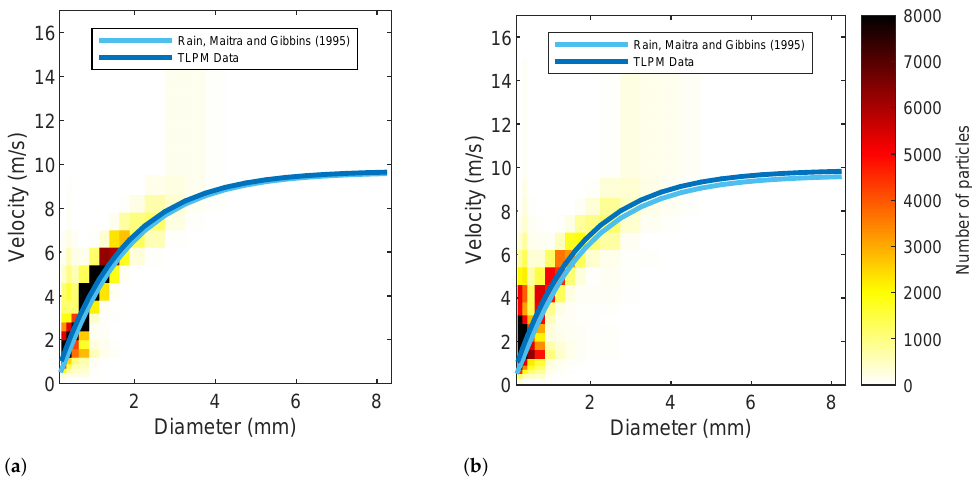
Figure 4. Relationship between raindrop velocity and raindrop diameter obtained from disdrometer data as compared with the Maitra and Gibbins model. ( a ) Moderate rainfall event (event 1 in Table 3), ( b ) heavy rainfall event (event 2 in Table 3).